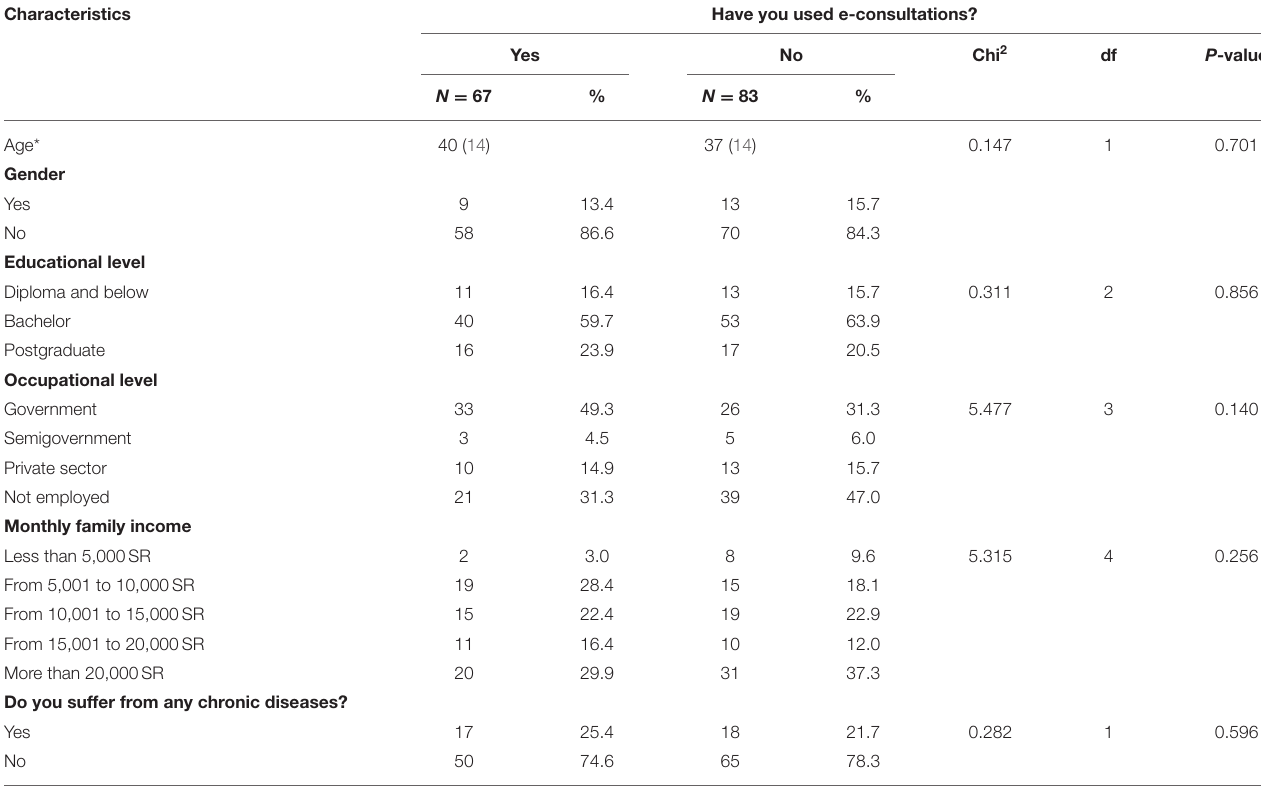
TABLE 2 | The influence of external variables between actual e-consultation users and never-users. Characteristics